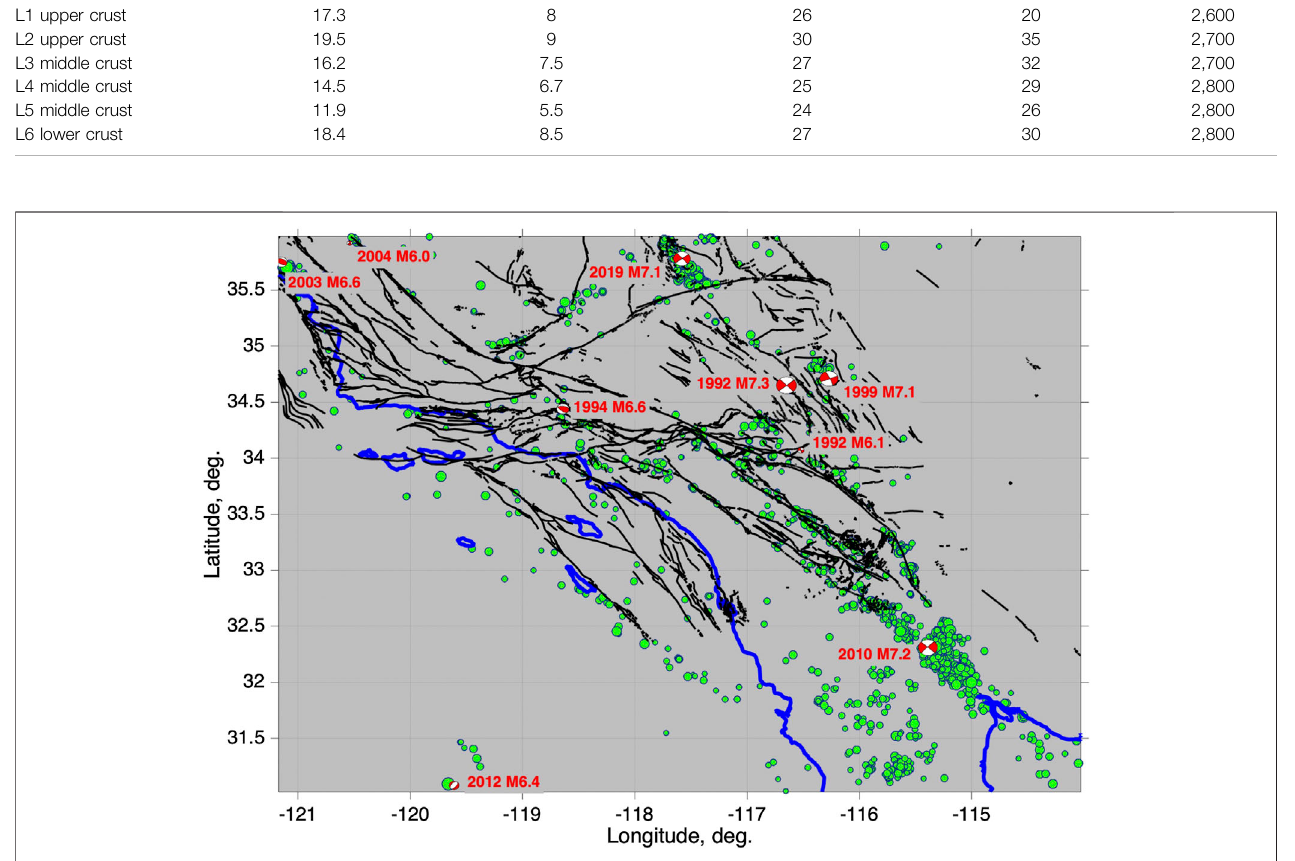
FIGURE1| Faulttectonics(blacklines,USGSdatabase)andseismicity(greencircles,ComCatdatabase)inthestudyarea.Beachballsandredtextlabelsindicate earthquake mechanisms, year, and magnitude of major shocks during the time interval from 1990 to 2020.